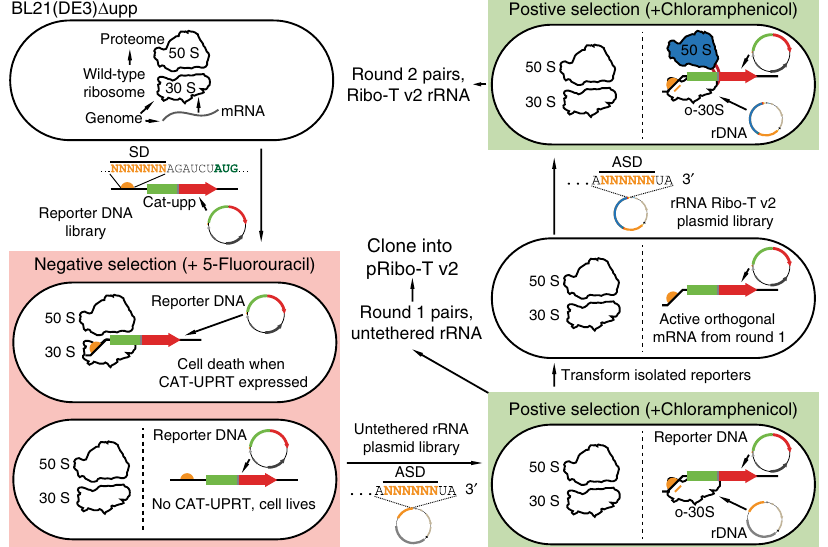
Fig. 4 Improving orthogonal pairs. Selection scheme to optimize orthogonal Shine-Dalgarno (SD) and anti-Shine-Dalgarno (ASD) pairs in untethered and tethered